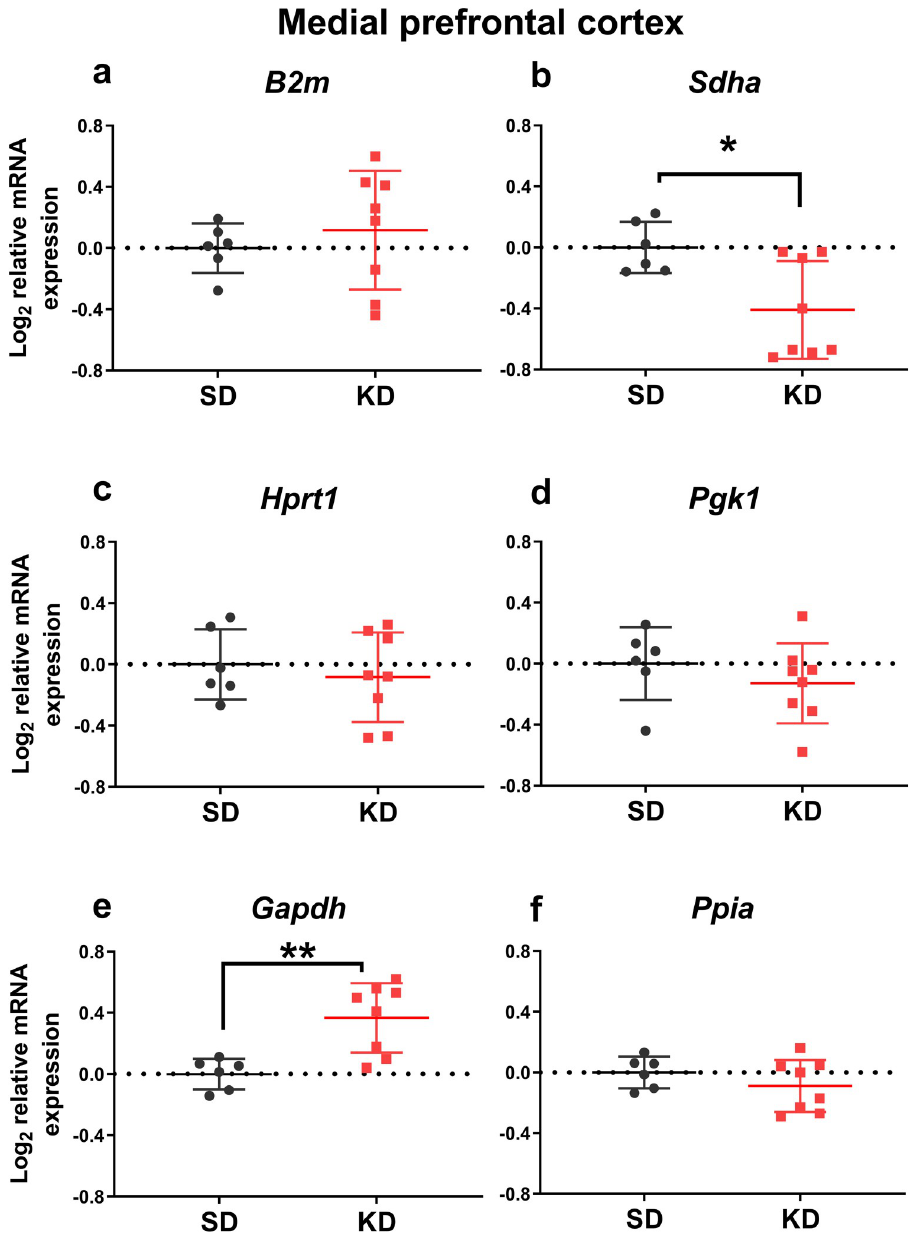
Fig 4. The effects of medium-chain triglyceride supplementation for 1 month on the mRNA expression of reference genes in the rat medial prefrontal cortex. MCT (2 ml/kg body weight) were given as a supplement to standard feed to adult animals (9 m.o., BW = 444 ± 69 g) by oral gavage daily for 4 weeks (KD), while the control rats received equivolume water (SD). The mRNA expression was normalized to the geometric mean of the expression level of the three most stably expressed genes ( Rpl13a , Actb , Ywhaz) . � – p < 0.05, �� – p < 0.01 (Student